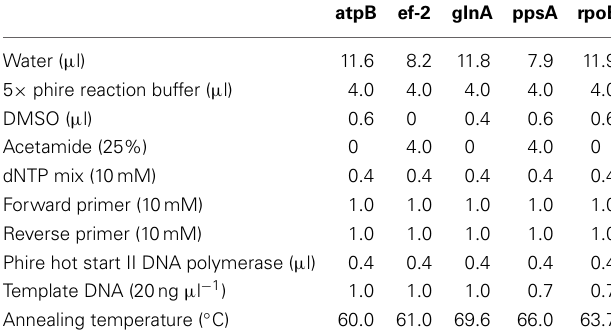
Table 2 | PCR conditions for each